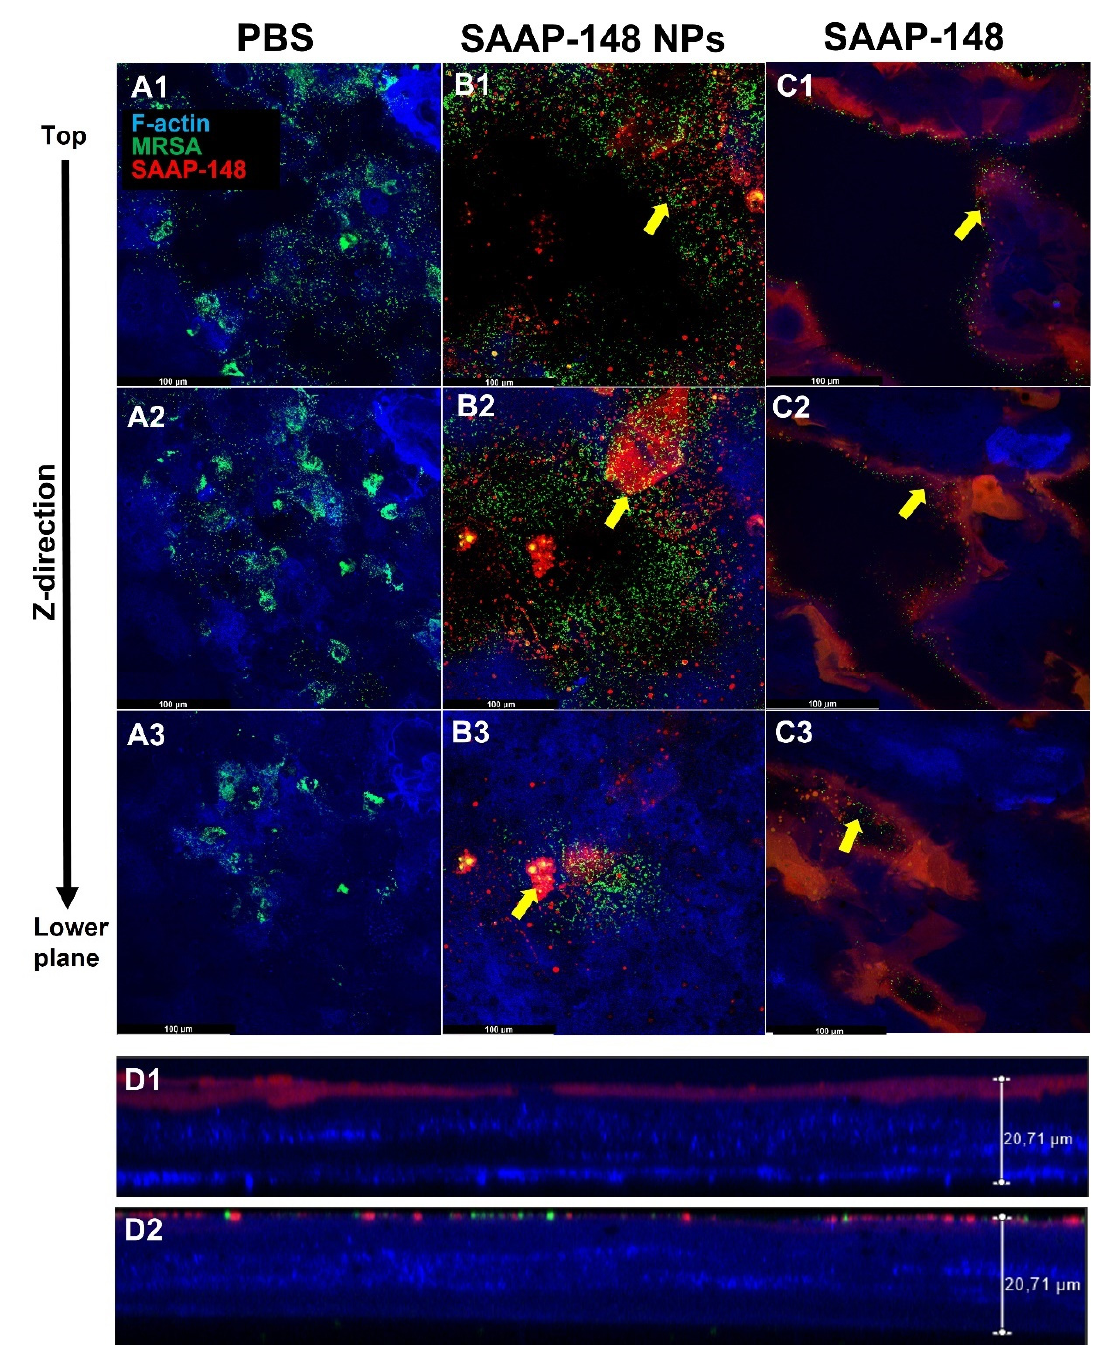
Figure 6. Representative confocal micrographs, taken across the Z-axis of 3D human skin equivalents (HSEs), are fluorescently labeled with Phalloidin (blue), infected for 1 h with GFP-labeled MRSA (green), and then, subsequently exposed for 24 h to ( A1 – A3 ) PBS, ( B1 – B3 ) 20 µM carboxytetramethylrhodamine (TAMRA)-labeled SAAP-148 NPs, or ( C1 – C3 ) 20 µM TAMRA-labeled SAAP-148 solution (red). Scale bar: 100 µM. Side view of ( D1 ) SAAP-148 solution, and ( D2 ) SAAP-148 treated 3D HSEs (thickness = ~20 µ m). Yellow arrows indicate colocalization of SAAP-148 NPs/SAAP-148 solution with bacteria on the top layer of the HSEs. Representative images are of observations from n = 3 independent experiments.